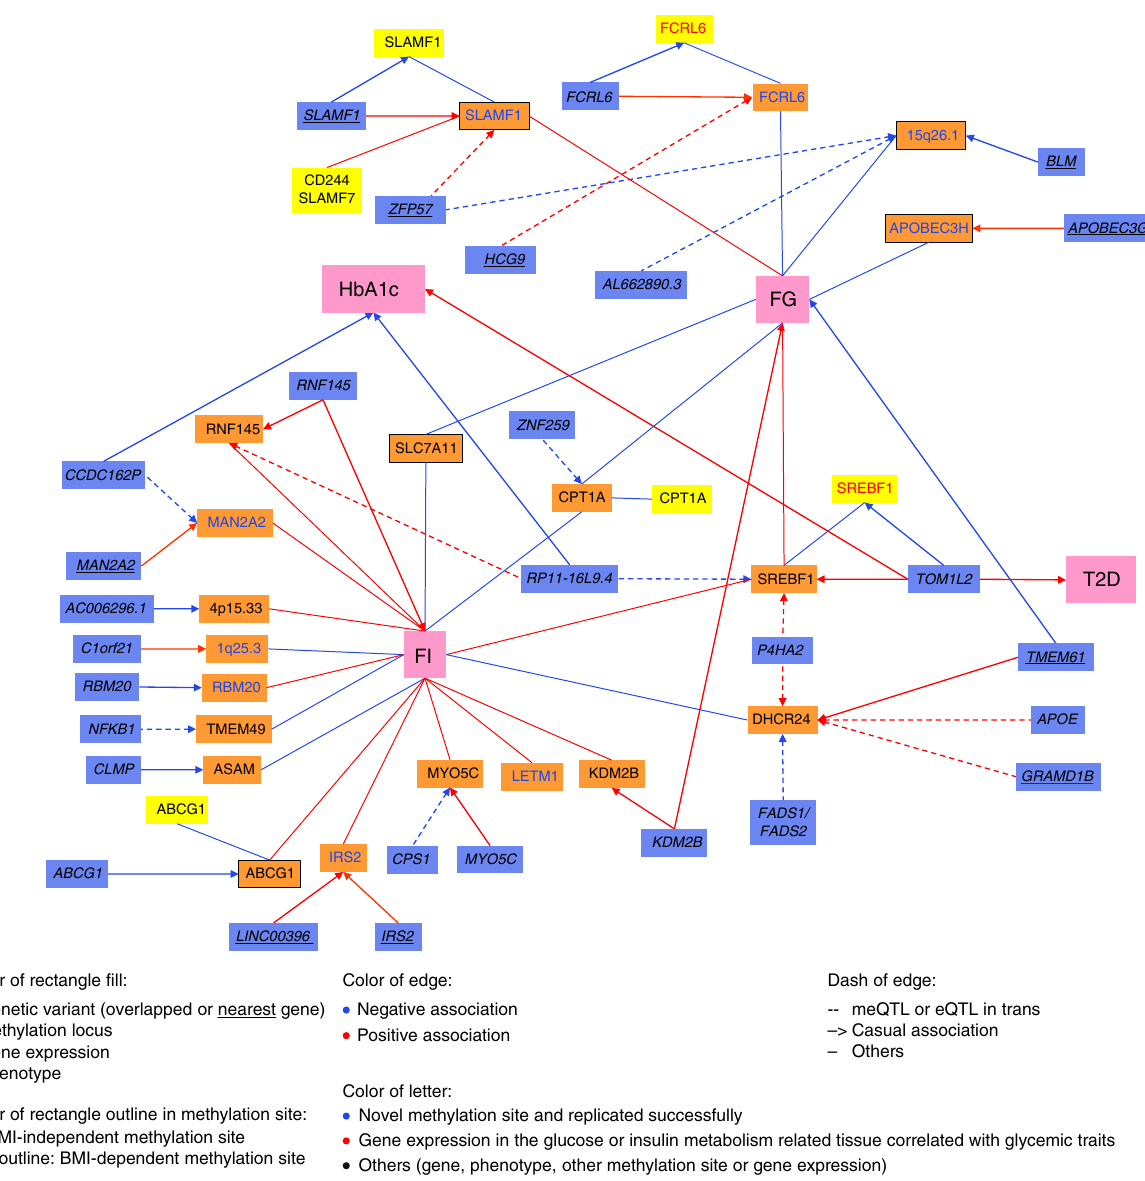
Fig. 2 Signi fi cant associations of the cross-omics integration. The effect allele is standardized across all associations. Only the signi fi cant associations which passed the speci fi c P value threshold in each association step and the direction of effects consistent were shown in the fi gure. FG fasting glucose. FI fasting insulin, T2D type 2 diabetes, HbA1c hemoglobin